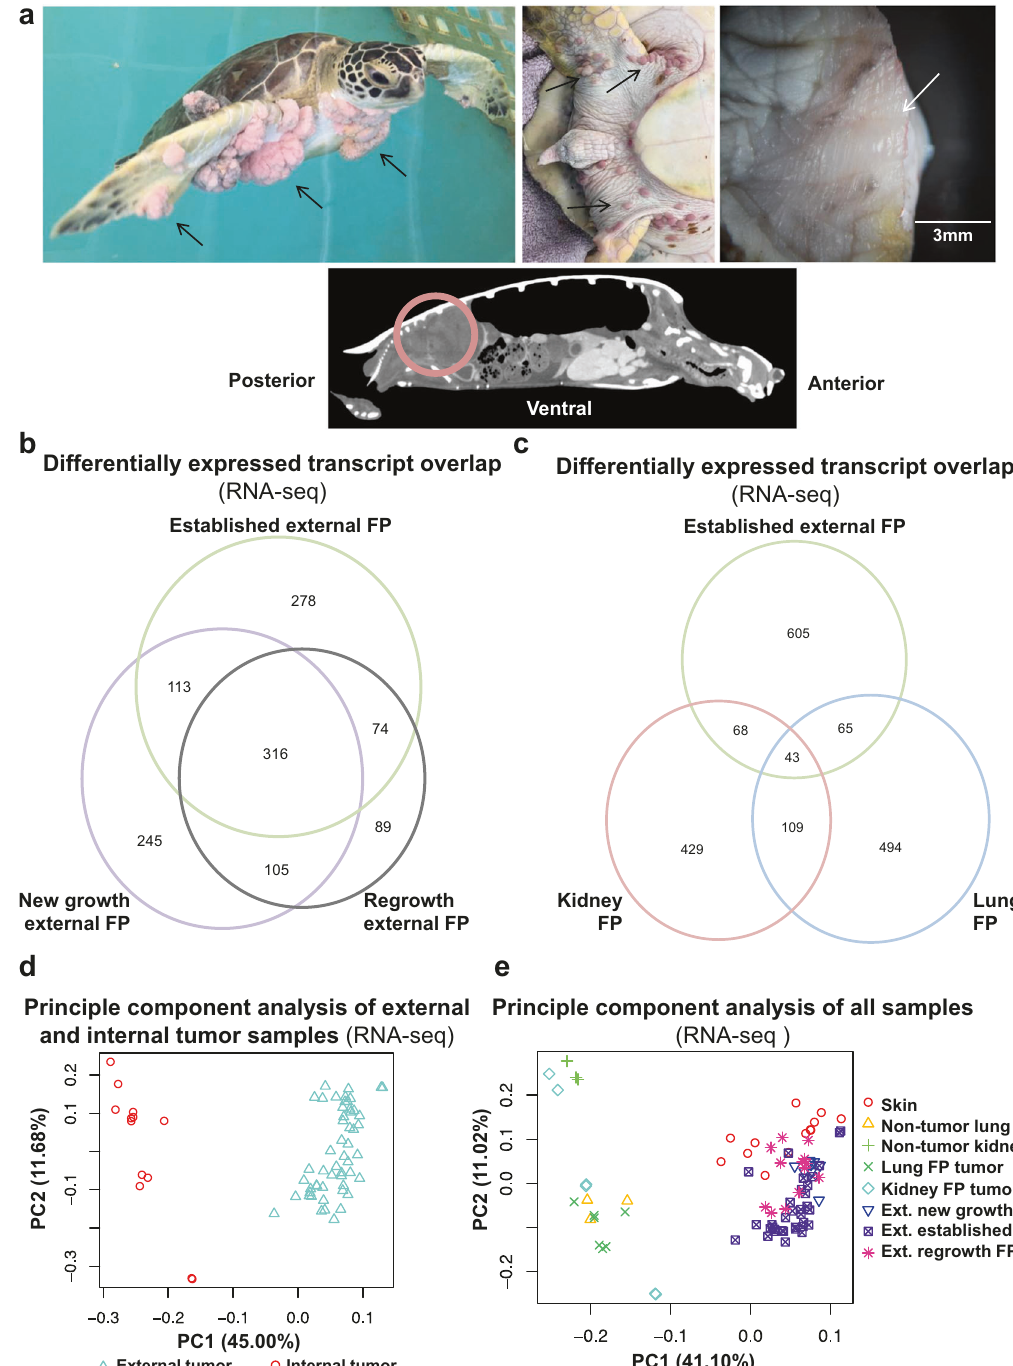
Fig. 1 Fibropapillomatosis tumors and differential transcript expression. a (Top, left) Fibropapillomatosis-af fl icted green sea turtles ( Chelonia mydas ) in one of the hospital ’ s seawater tanks, awaiting tumor removal surgery. Established tumors are visible as large pinkish outgrowths. Top, middle: Numerous new growth tumors occurring around the ventral tail and rear fl ipper area of patient 25-2018-Cm ‘ Lilac ’ . Top, right: Postsurgical regrowth tumor imaged after surgical resection. Regrowing tumor is the pinkish tissue, and is surrounded by paler non-tumored skin. Bottom: A computed tomography (CT) scan of fi bropapillomatosis-af fl icted C. mydas . CT is one of the approaches used for diagnosing internal tumors. A large kidney tumor is circled. In all other images, arrows indicate selected examples of external tumors. b , c Overlap of transcripts signi fi cantly differentially expressed (DE) (as called by DESeq2) in fi bropapillomatosis from the RNA-seq data. Transcripts were considered signi fi cant if passing the following cutoffs: adjusted P value of <0.05 and log 2 fold change of >2 or ≤ 2. b Overlap of DEs from the following comparisons: established external FP, new growth external FP, and regrowth external FP, when all are compared to healthy skin for differential expression analysis. c Overlap of DEs from the following comparisons: established external FP, kidney FP, and lung FP, each compared to their non-tumored tissue sources for differential expression analysis (healthy skin, healthy kidney, and healthy lung, respectively). d Principle component analysis (PCA) of all internal tumor samples compared to external tumor samples, RNA-seq. e PCA of all samples, includes all tumor and nontumor samples, RNA-seq. In the fi gure key external is abbreviated as ‘ Ext. ’